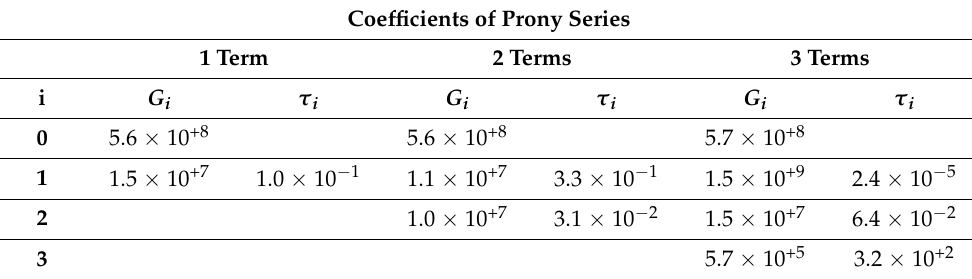
Table 5. Prony series for material ABS at temperature T = 20 °C.